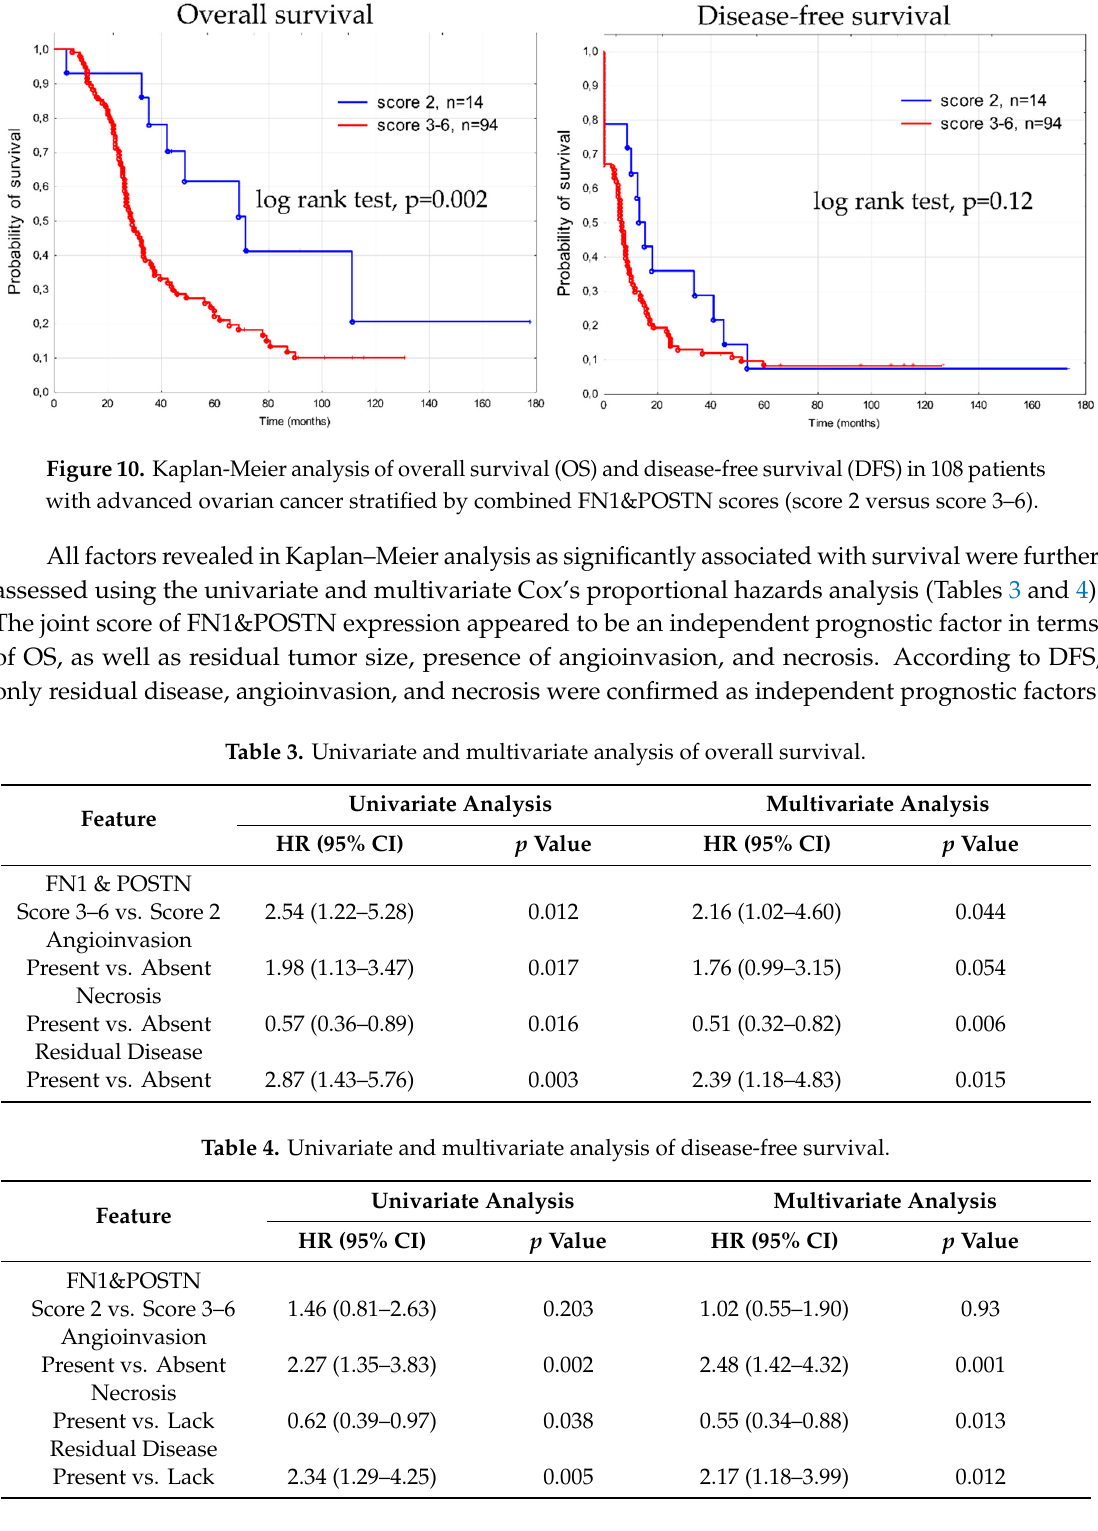
Table 4. Univariate and multivariate analysis of disease-free survival.